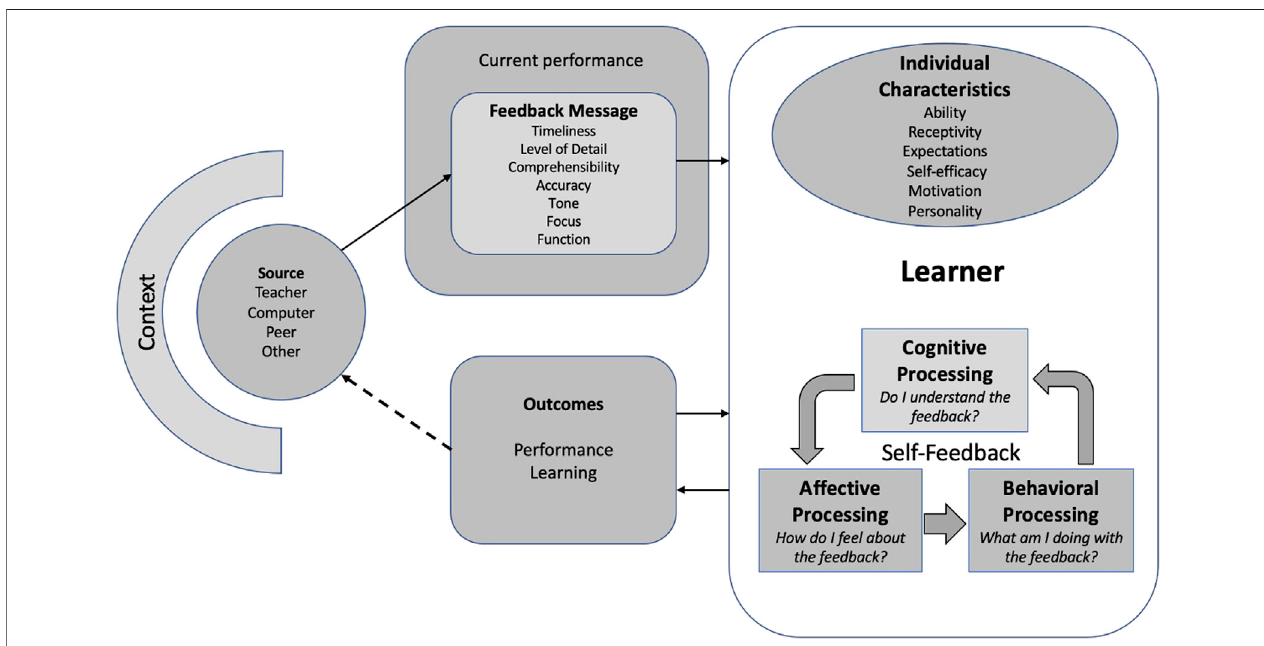
FIGURE 15 | Student-feedback interaction Model (Revised).